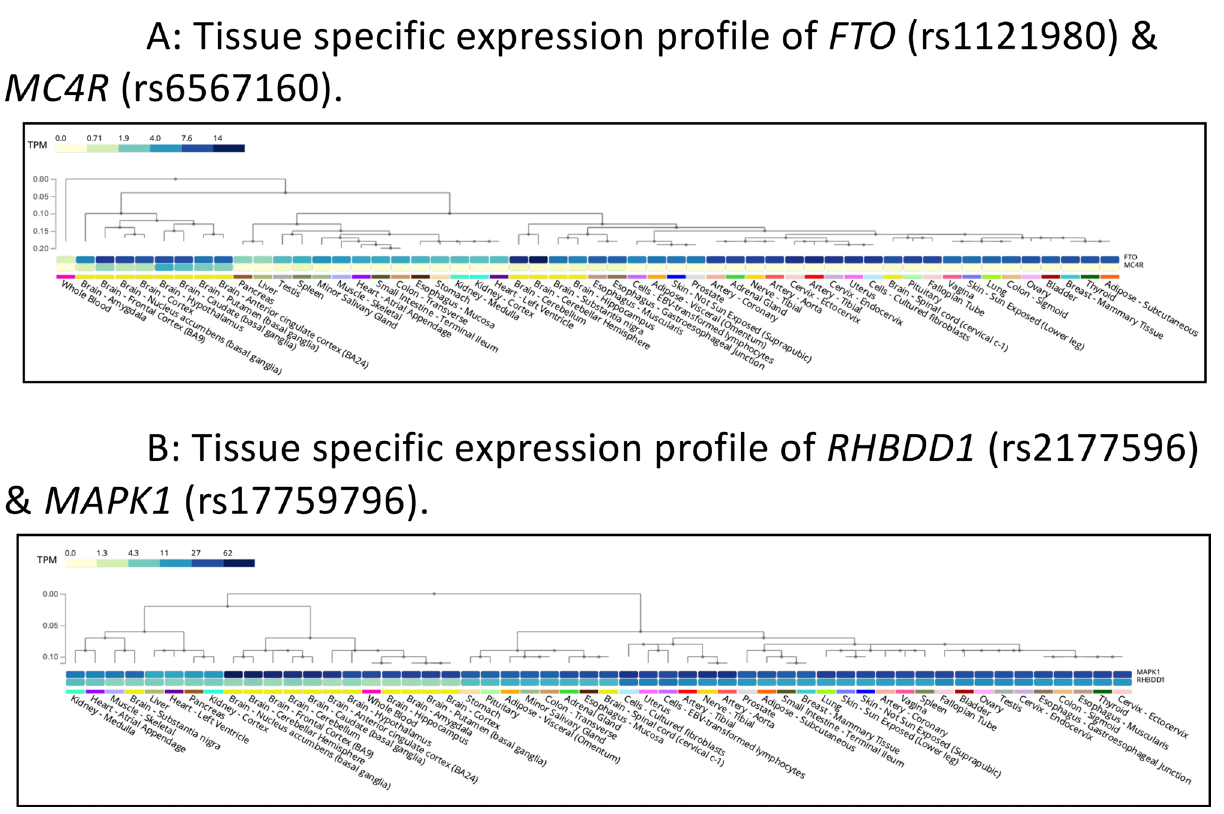
Figure 3. ( A ) Tissue specific expression profile of FTO (rs1121980) and MC4R (rs6567160). Comparison of expression (TPM) across various tissues, generated from GTeX for the genes FTO and MC4R . ( B ) Tissue specific expression profile of RHBDD1 (rs2177596) and MAPK1 (rs17759796). Comparison of expression (TPM) across various tissues, generated from GTeX for the genes RHBDD1 and MAPK1